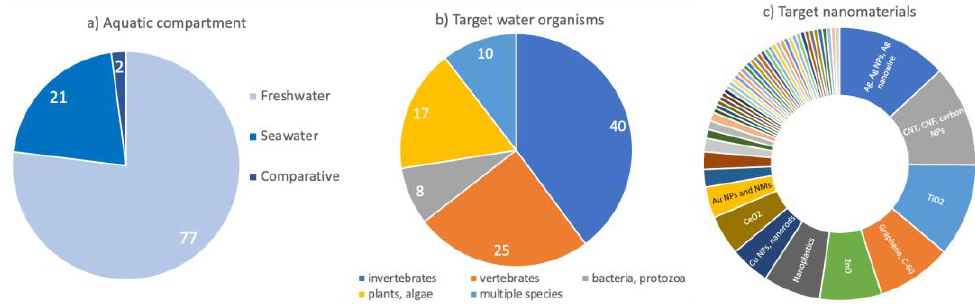
Figure 4. Overview of the selected papers targeting the ecotoxicity of nanomaterials in the aquatic environment classified according to the ( a ) different aquatic compartments; ( b ) the main target organisms; and ( c ) nanomaterials.